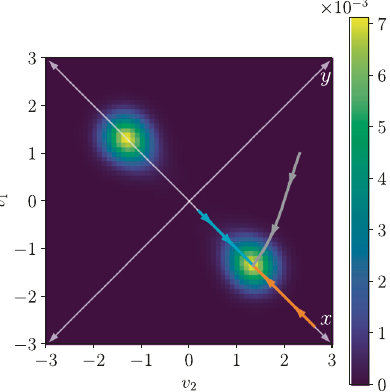
Fig.1|SteadystateanddeterministictrajectoriesfortheCMOSmemory. Exact steady state distribution for V dd =1.4 and v e =0.1. The orange, cyan and grey lines show three deterministic trajectories for the same parameters and different initial conditions, with the arrows indicating the direction of